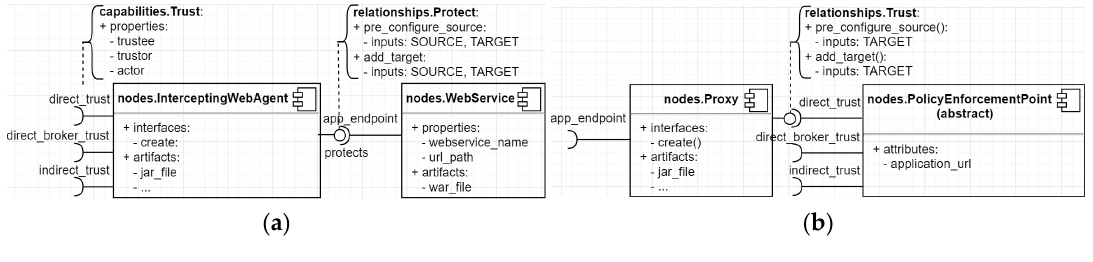
Figure 6. ( a ) Protect relationship; ( b ) Trust relationship.